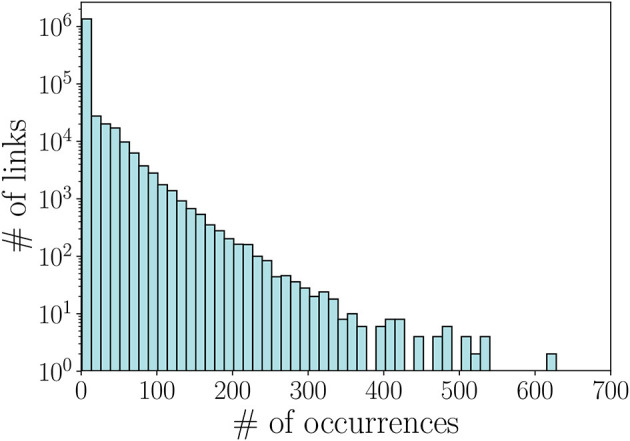
Distribution of the number of occurrences per link, i.e., number of times a couple of teammates play together.